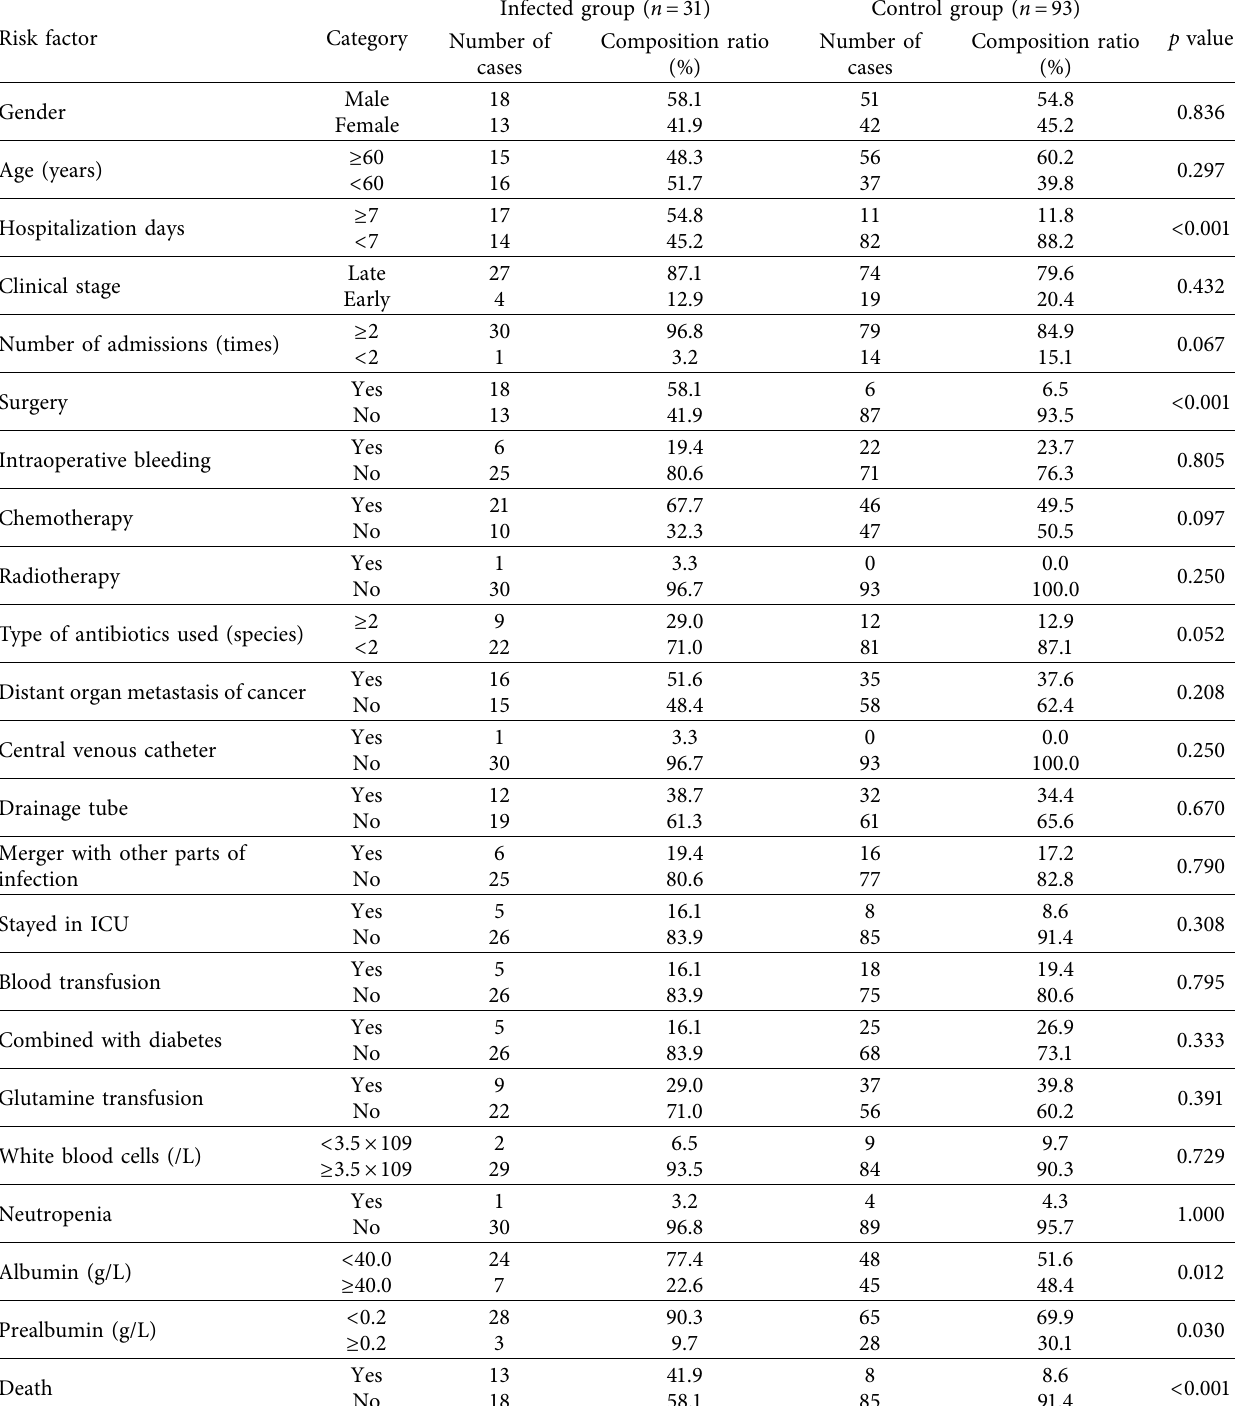
Table 3: Analysis of risk factors for E. coli BSI in patients with pancreatic